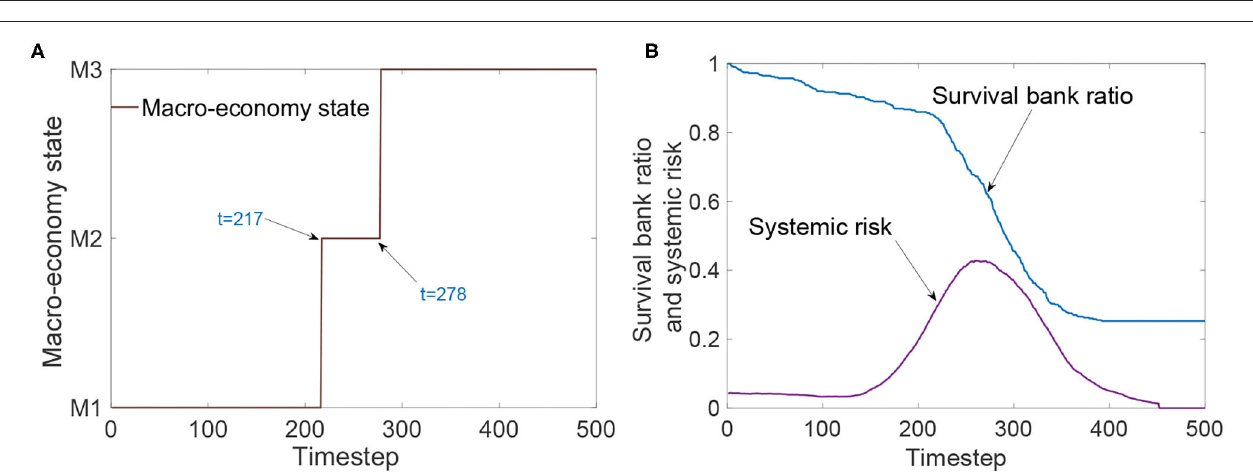
FIGURE 6 | (A) Representation of the changes in macroeconomy states with the evolution of the banking system with shadow banking. (B) Representation of the changes in bank survival ratio and systemic risk of the banking system with shadow banking.